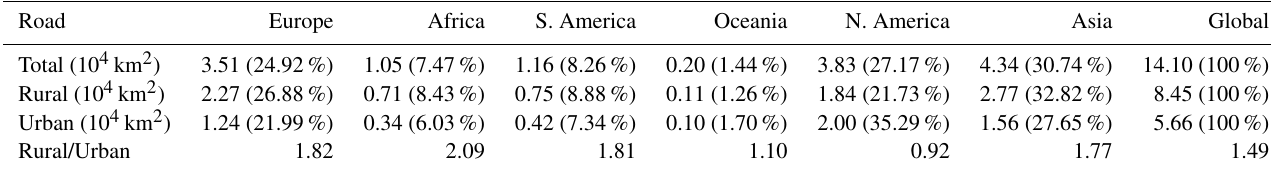
Table 7. Statistics for the road area derived from GISA-10m and OSM in the six continents. Road